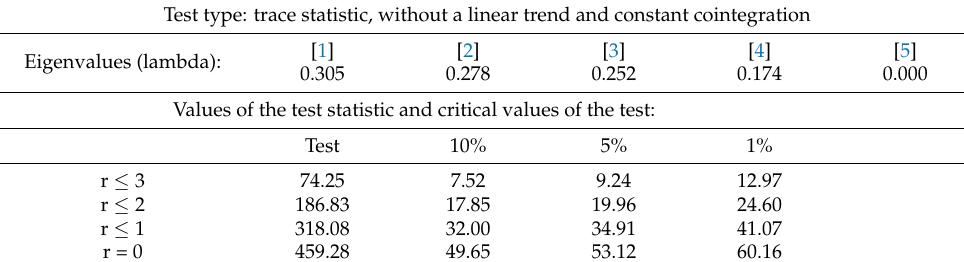
Table 4. Johansen cointegration test with trace statistics and maximal eigenvalue. Test type: trace statistic, without a linear trend and constant